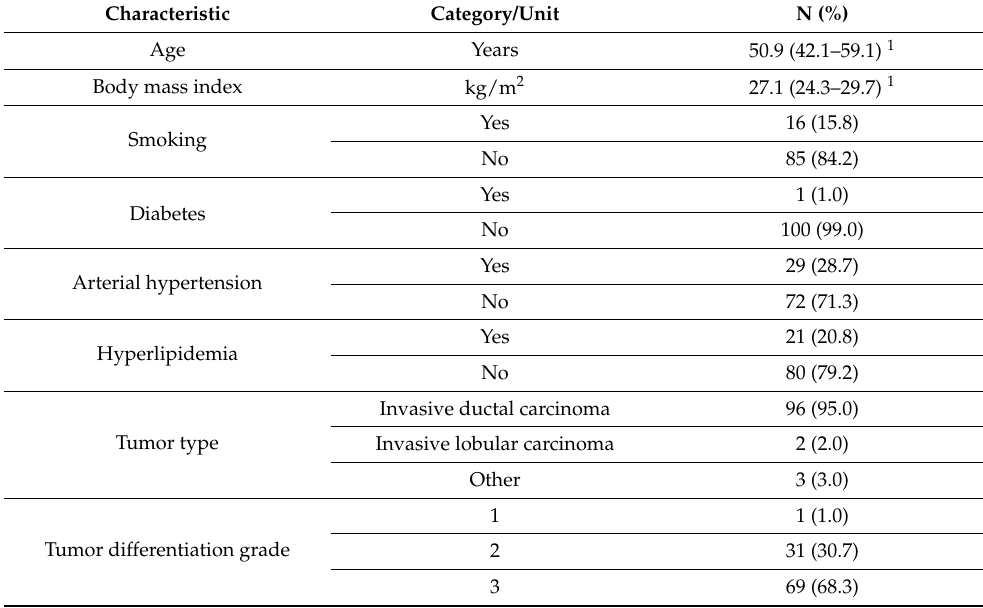
Table 1. Clinical characteristics of breast cancer patients included in the study (N = 101).